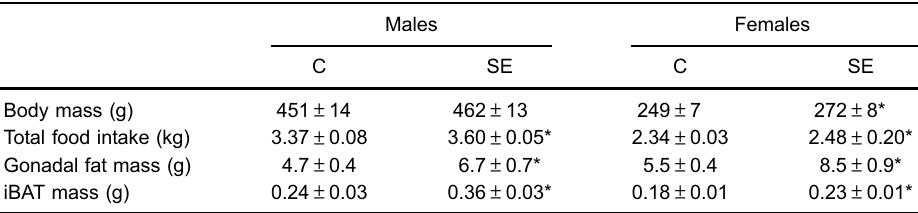
Table 2. Long-term effects of neonatal cigarette smoke exposure on body mass, food intake, visceral fat mass, and iBAT mass in 180 postnatal